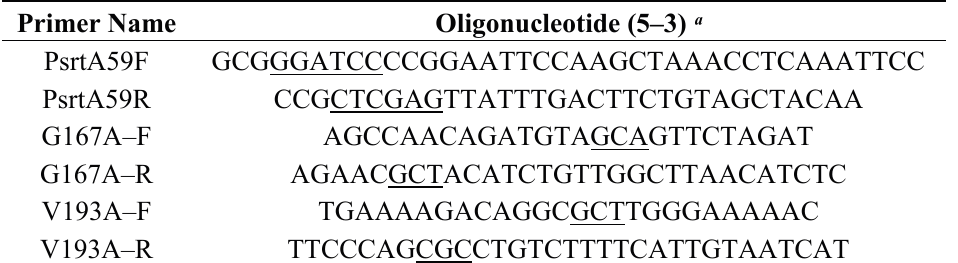
Table 4. Oligonucleotide primers used in this